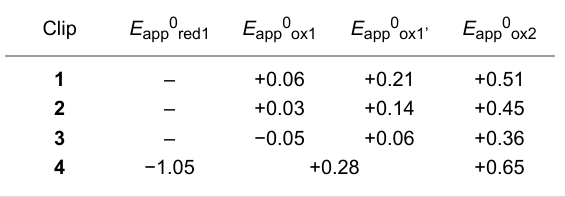
Table 2: Apparent redox potentials of molecular clips 1, 2, 3 and 4 reported vs Fc + /Fc in 0.1 M TBAPF 6 /CH 2 Cl 2 /CH 3 CN 3:1 on